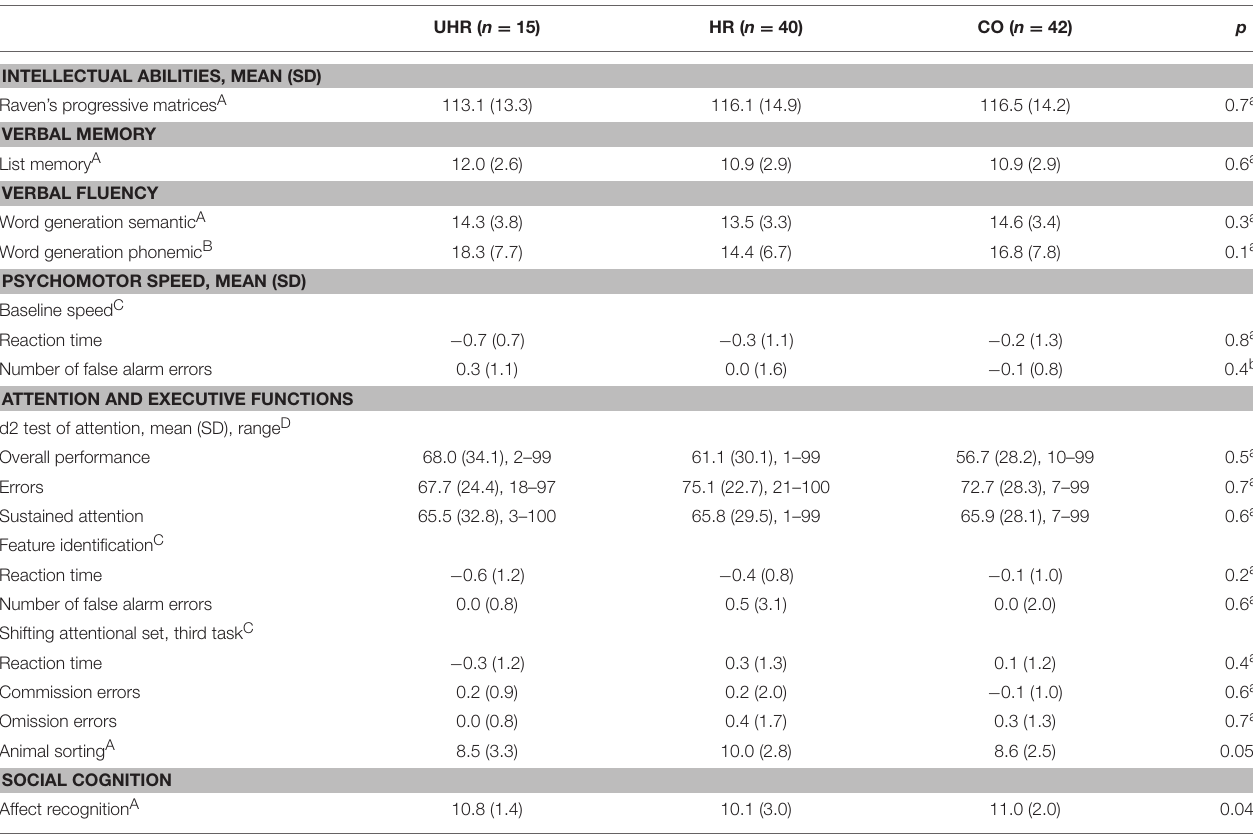
TABLE 4 | Neuropsychological characteristics of the UHR, HR, and CO